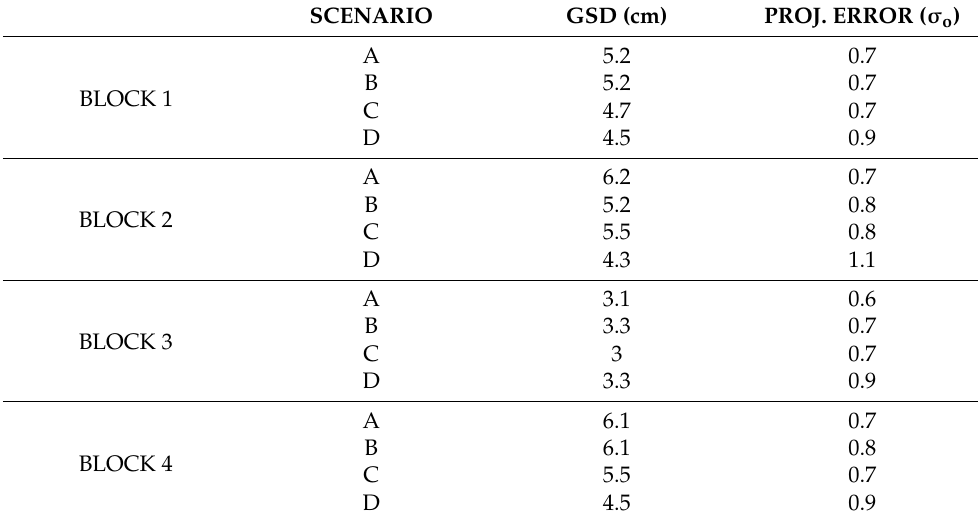
Table 6. Parameters for the calculation of µ XYZ from the adjustments using Agisoft Metashape for each scenario in the four blocks.